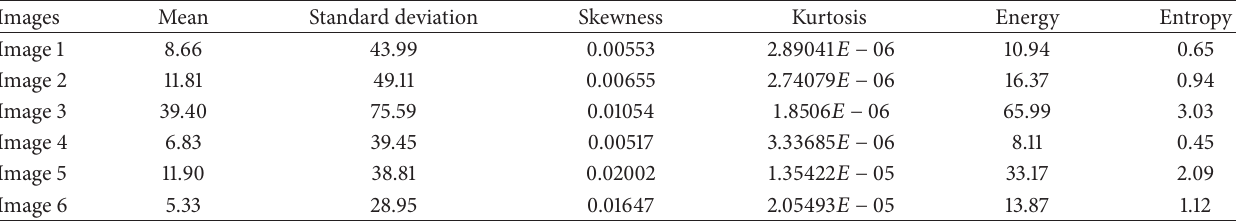
Table 1: First-order statistical features for few images.